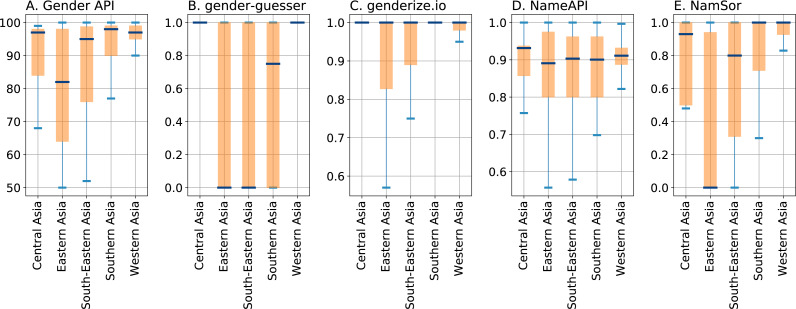
Boxplots depicting quartiles for the confidence parameters of the gender inference services for Asian subregions as returned by NamSor’s origin API, with boxplot settings as in Fig. 3.